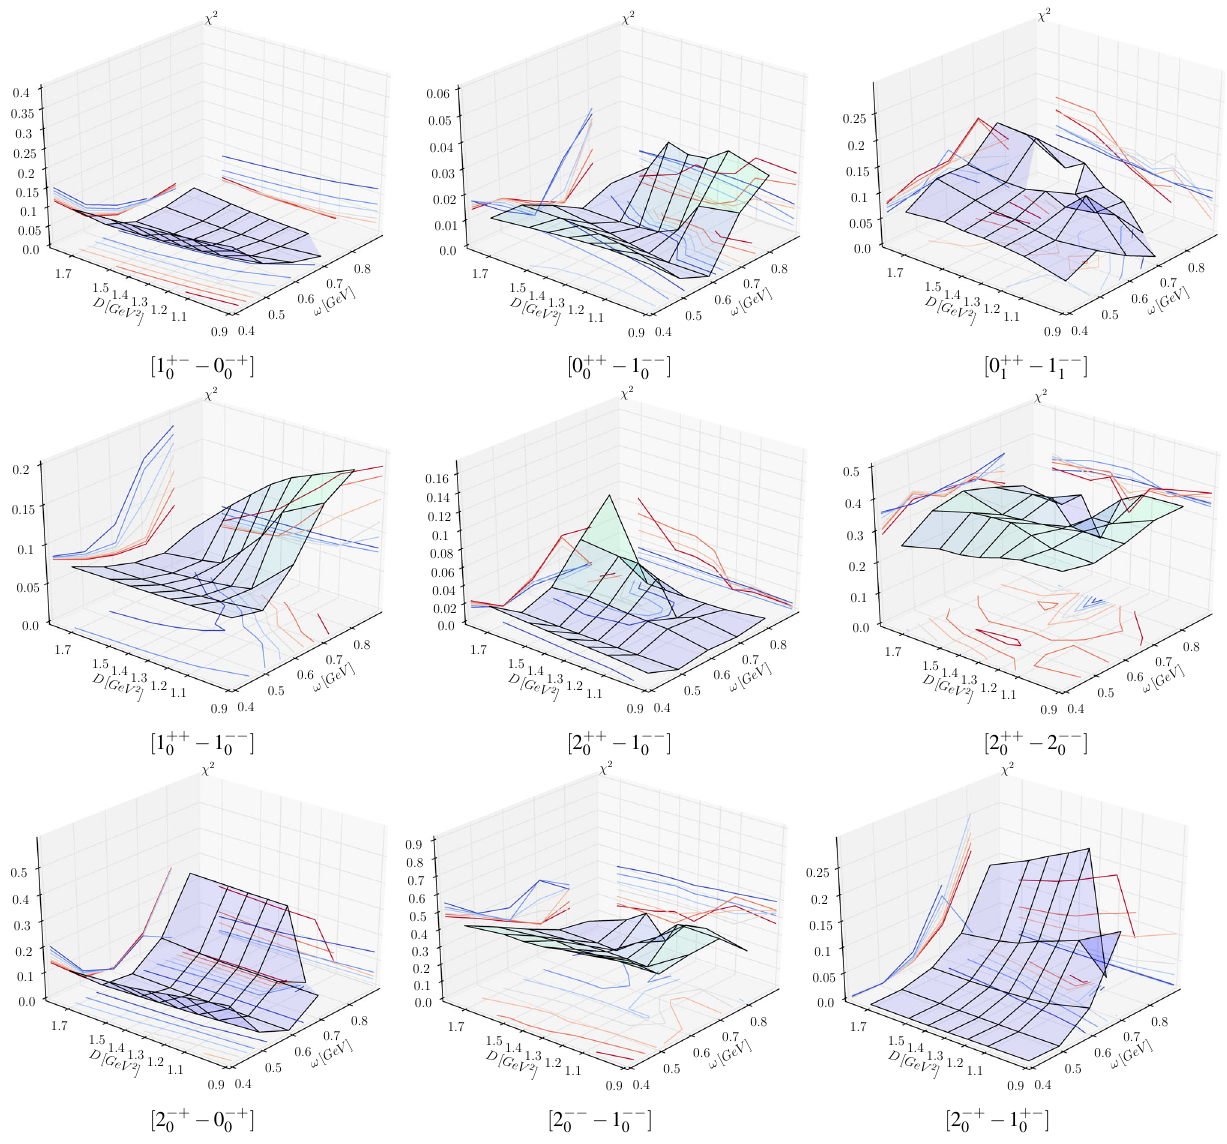
Fig. 19 χ 2 plot from the comparison of our calculated and the experimental orbital splitting as a function of ω and